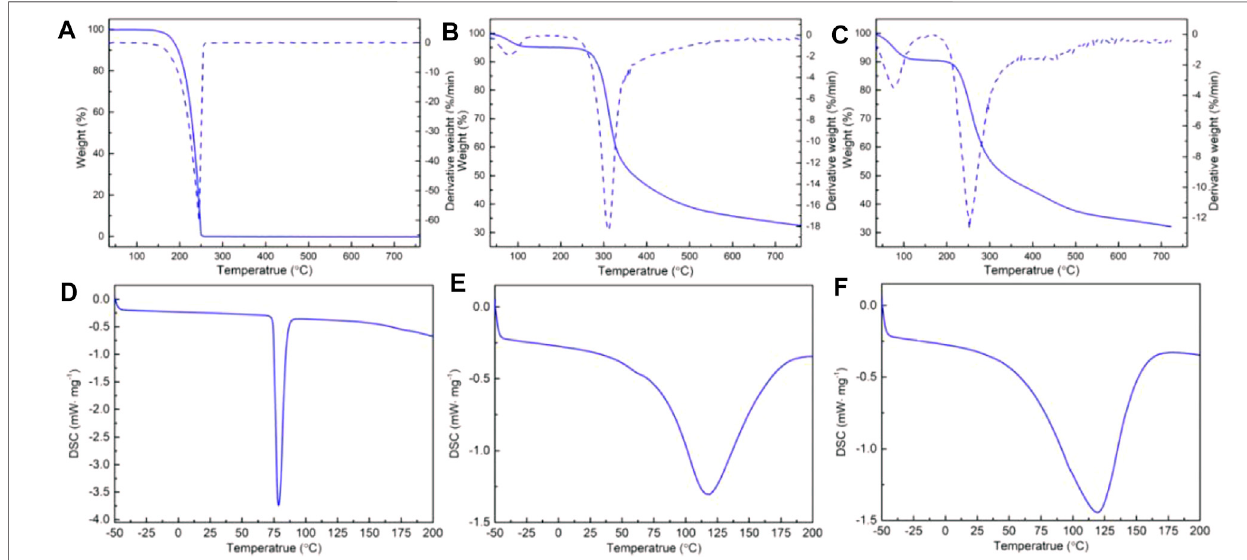
Frontiers in Chemistry |